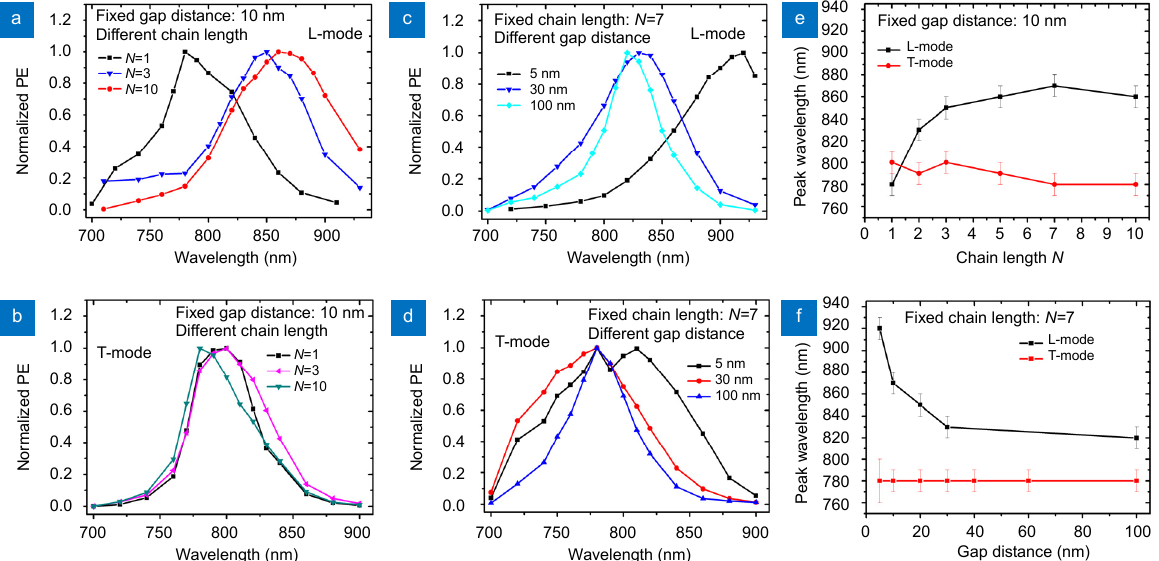
Fig. 3 | Near-field spectra of nanochains with a fixed gap distance of 10 nm but with three different chain lengths for ( a ) L-mode and ( b ) T-mode surface plasmons. ( c, d ) near-field spectra of nanochains with fixed chain length ( N= 7) but three different gap distances for L-mode and T-mode surface plasmons, respectively. ( e, f ) Summary of the dependence of both plasmon resonance peak wavelength on the chain length (e) and gap distance (f). The error bars in (e) and (f) are mainly  10 nm, which is mainly resulted from the wavelength scan step of 10 nm. The origin of such measurement errors can account for the observed difference in peak wavelength between the L-mode and T-mode for a chain length 1 in